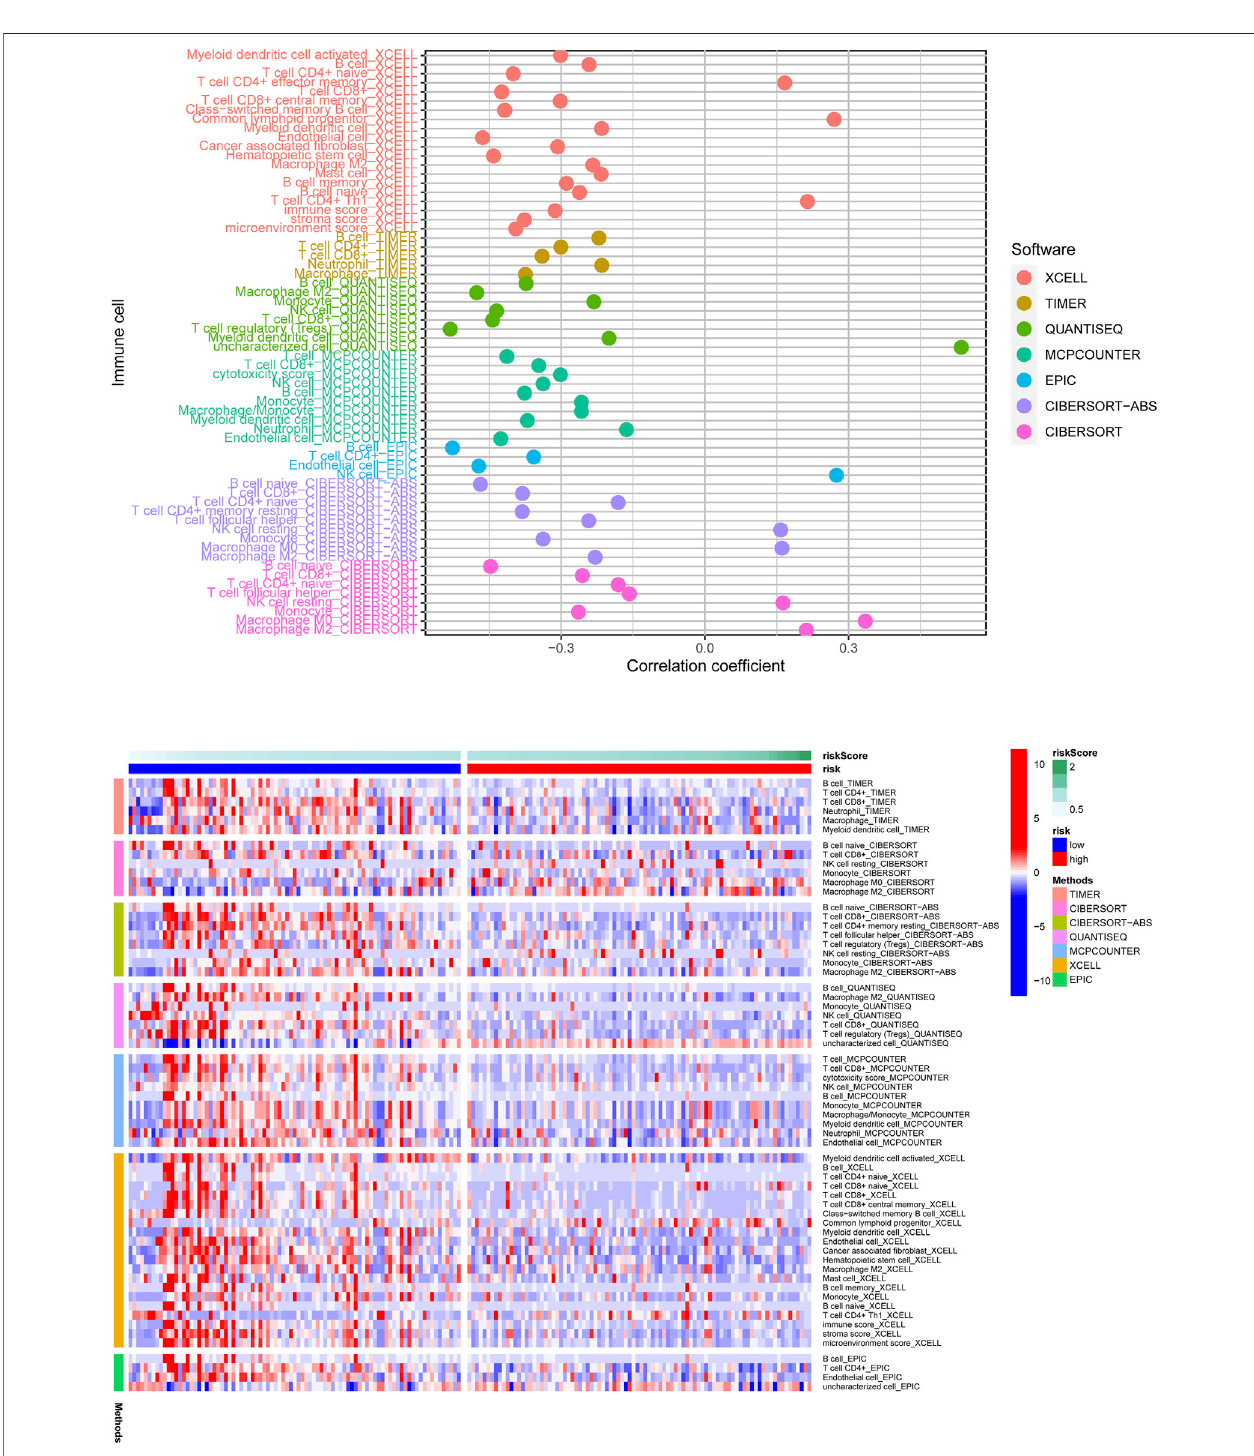
FIGURE 8 | The correlation of risk scores and immune cells in fi ltration was analyzed through multiple immune in fi ltration algorithms, and the result was shown with the lollipop plot (upper) and heatmap (below). Most immune cells were negatively related to the risk score observed from the result.